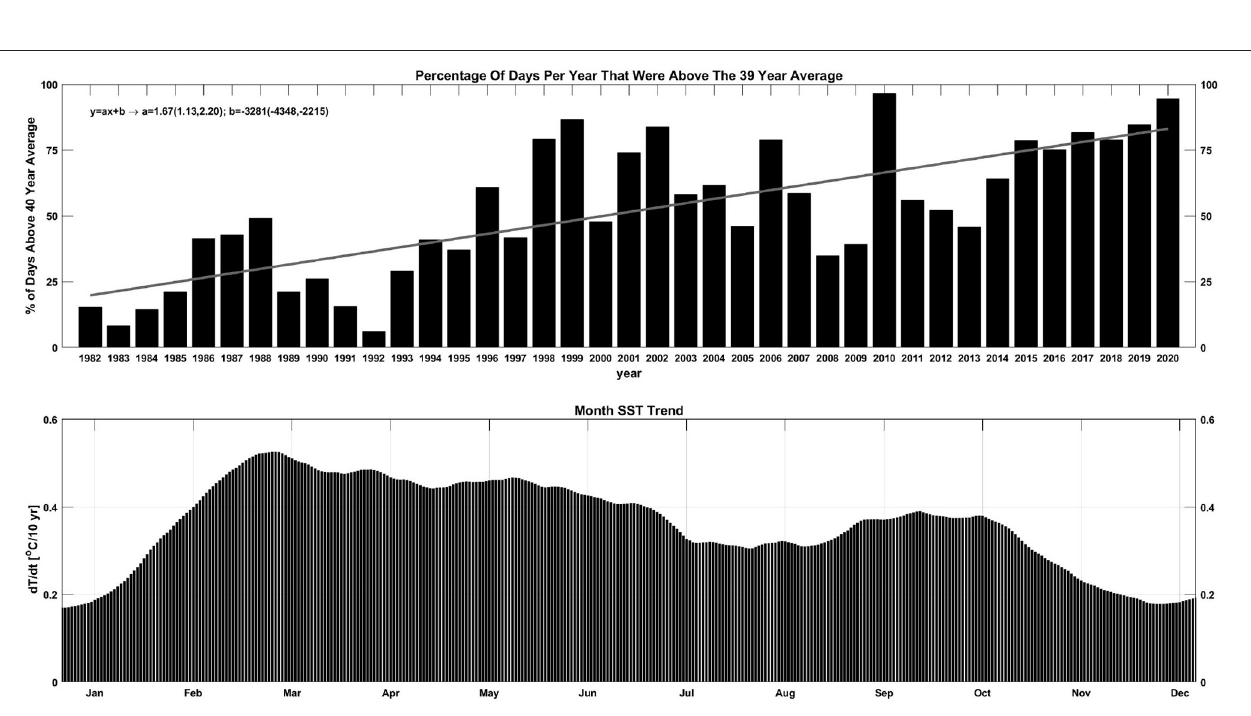
Frontiers in Marine Science |